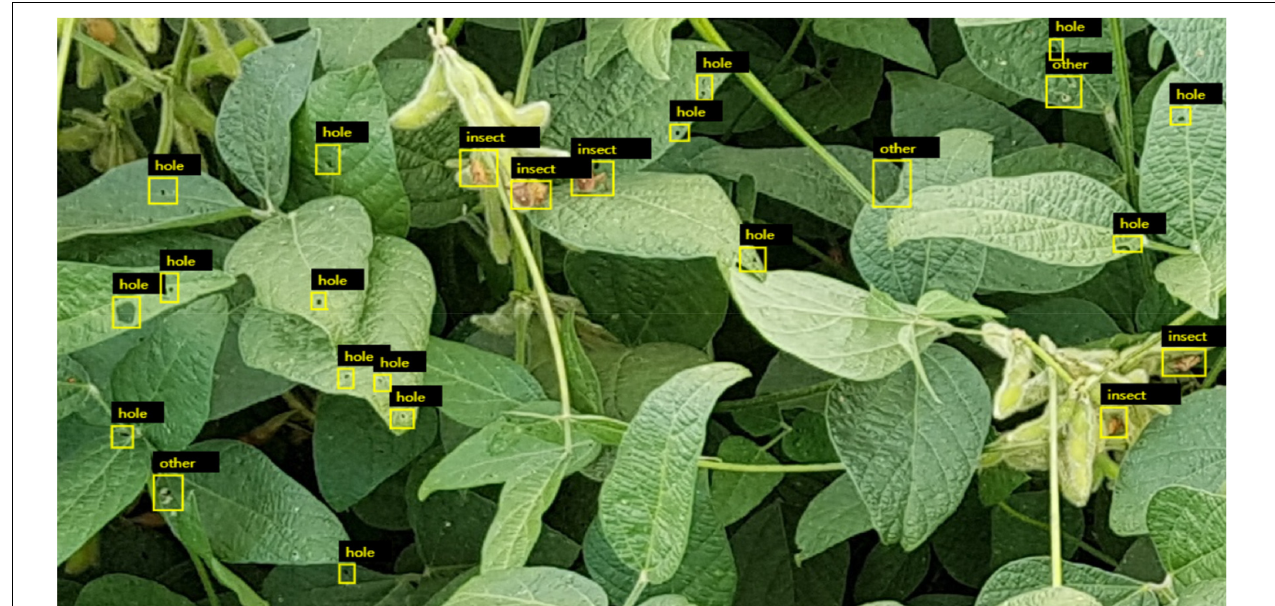
FIGURE 6 | Preliminary labeling pictures of leaf diseases and insect